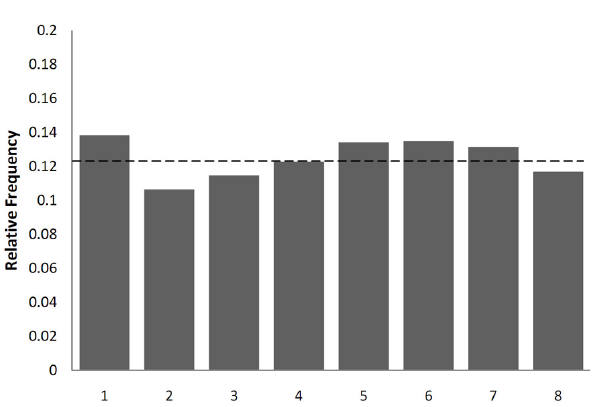
Fig. 8. Probability Integral Transform (PIT) histogram of calibrated BMA